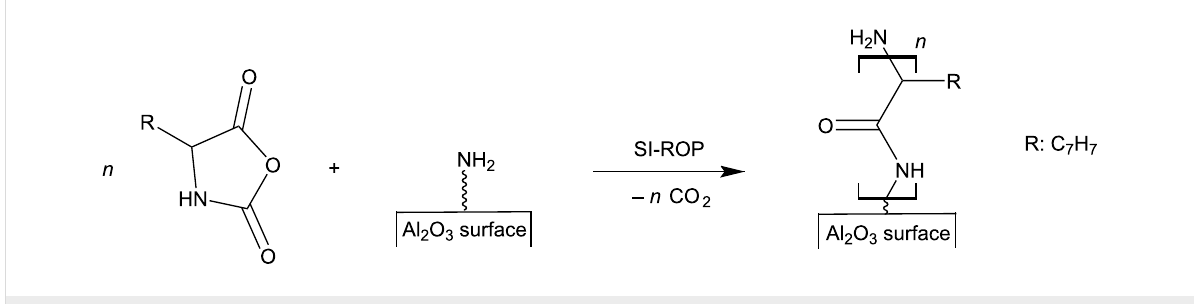
Figure 3: Surface-initiated ring-opening polymerization of